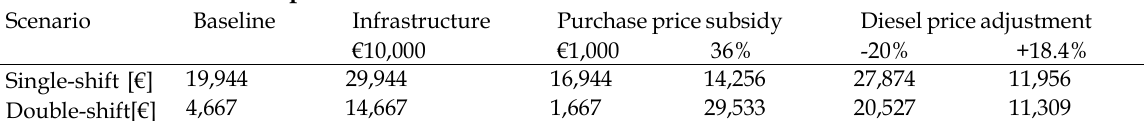
Table 7. ∆ TCO of the 5 t Sprinter vehicles in different